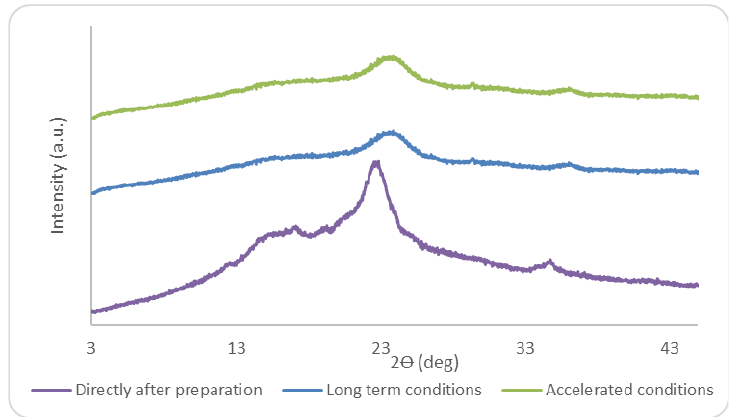
Figure 6. X-ray diffraction of minitablets after six months of storage in long-term (25 °C/60% RH) and accelerated (40 °C/75% RH) conditions. and accelerated (40 ◦ C/75% RH)